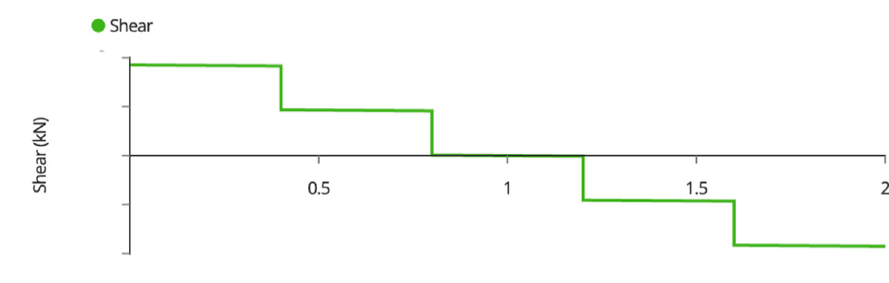
Figure A2. Joist Shear Force Diagram.